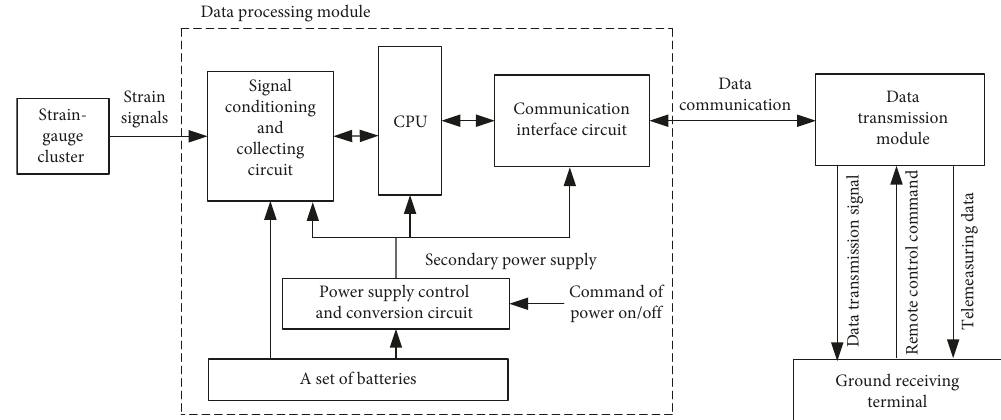
Figure 3: System composition of the vibration measuring